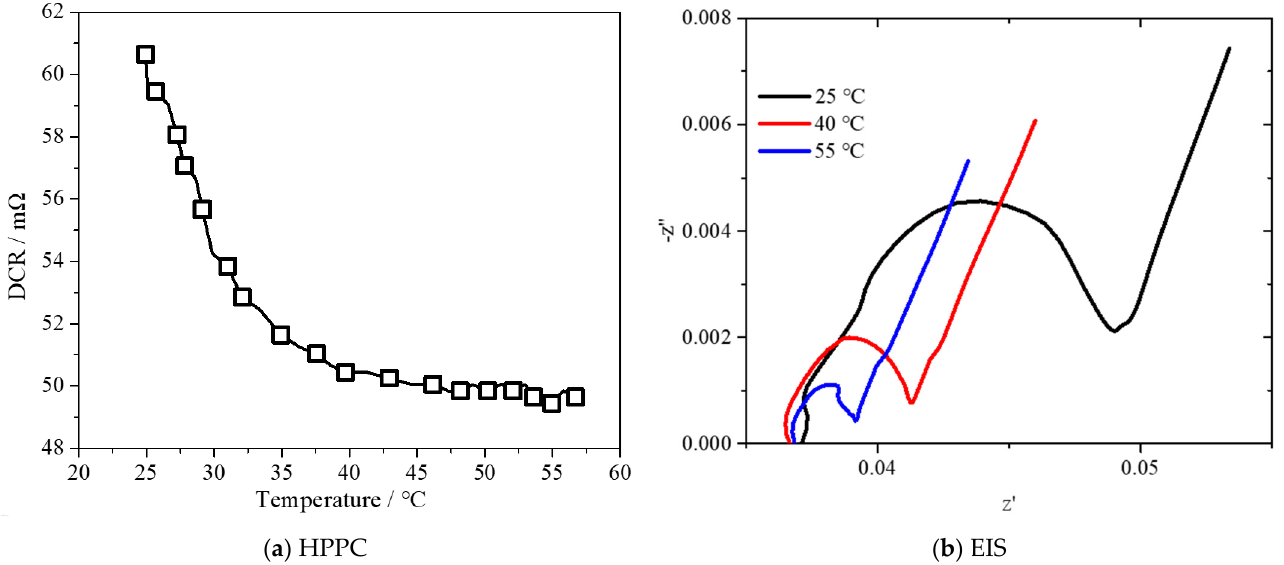
Figure 14. IR measured by electrochemical impedance spectroscopy (EIS) and HPPC (100% SOC), under different temperatures.